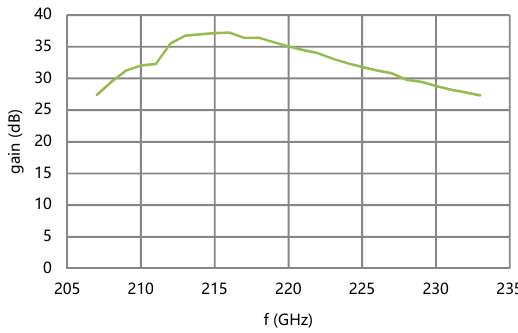
Table 2. The simulation results of different frequency. Figure 11. Saturation gains of the circuit. Figure 11. Saturation gains of the circuit.